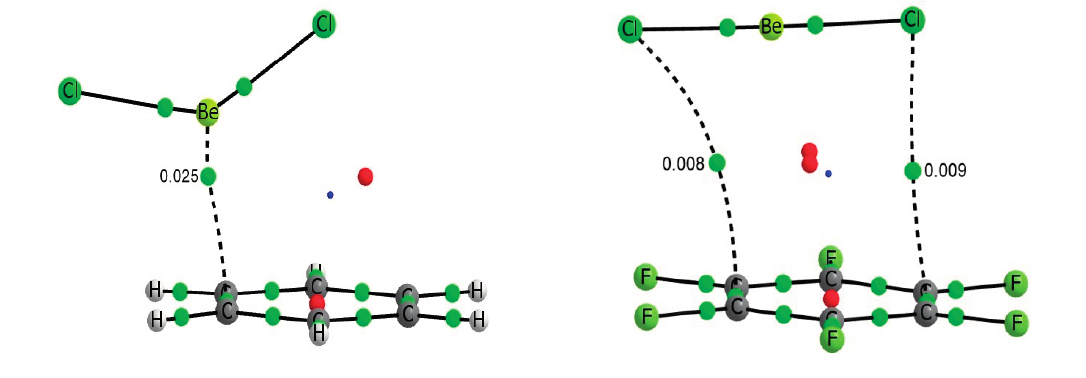
Figure 2. Molecular graph of BeR 2 :C 6 H 6 (R = H, Cl) ( left ) and BeR 2 :C 6 F 6 (R = H, Cl) ( right ) binary complexes. Green, red and blue dots denote BCPs, ring critical points and cage critical points respectively. The value of the electron density at the intermolecular BCP is indicated.